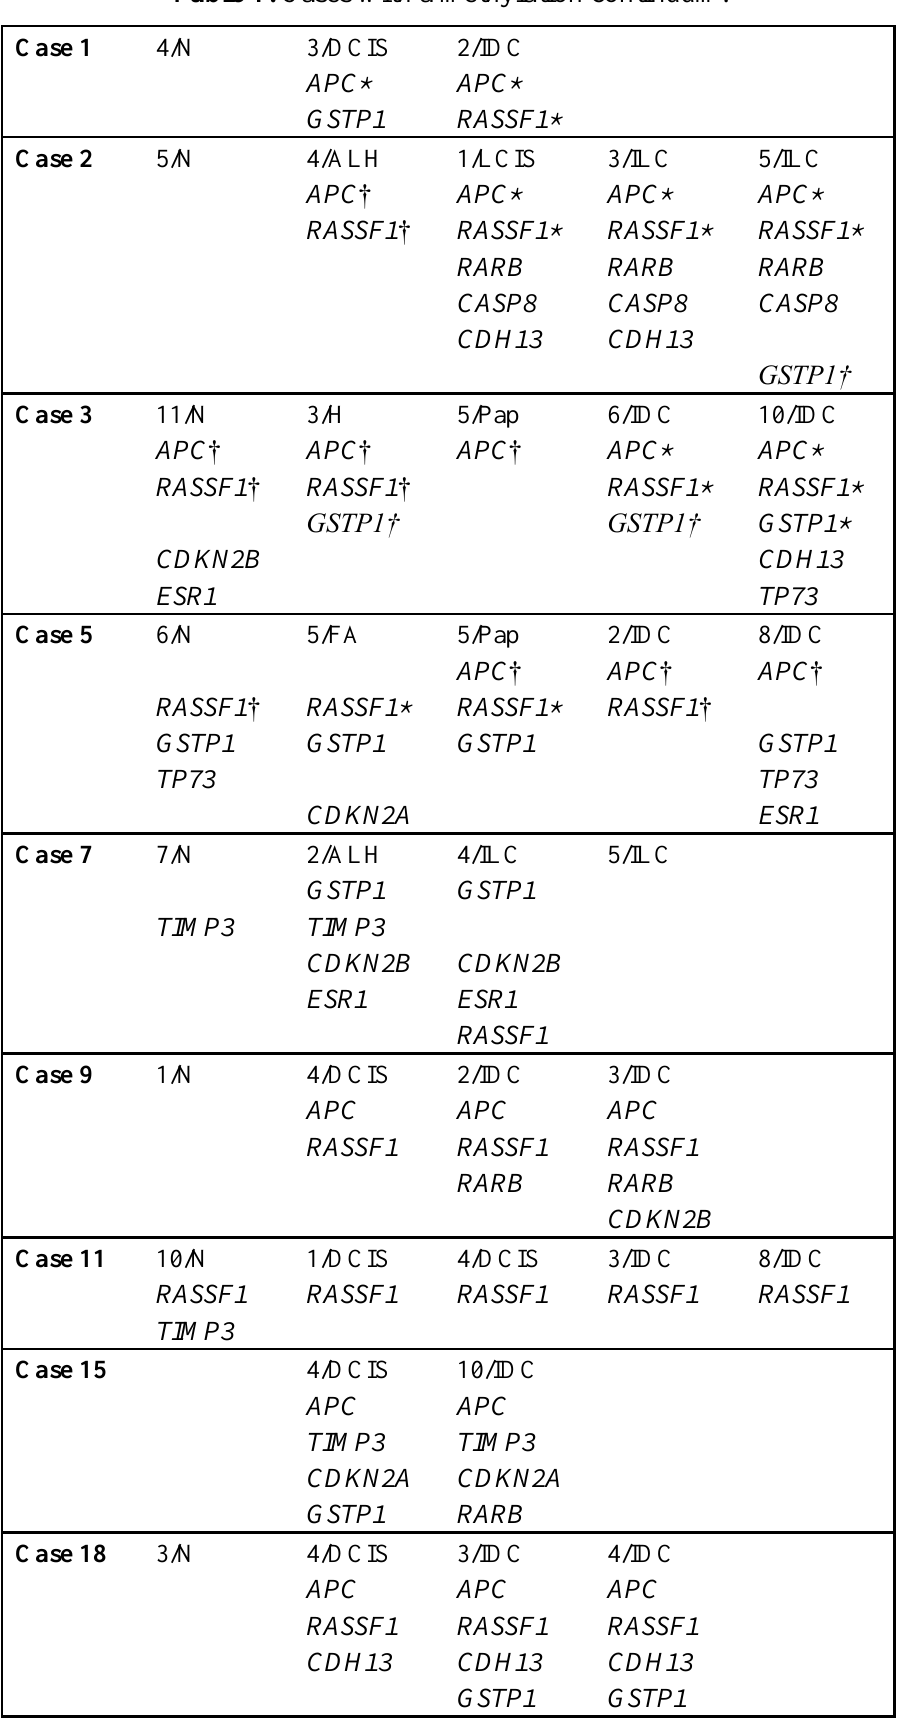
Table 1. Cases with a methylation